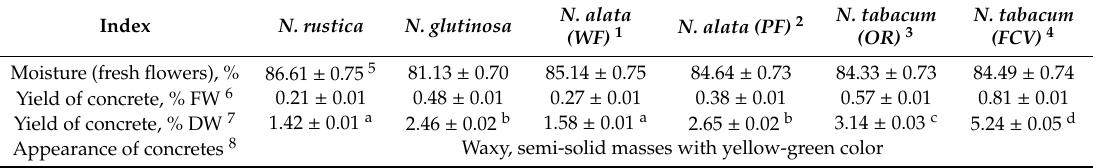
Table 1. Basic indices of the plant material ( Nicotiana flowers) and the obtained concretes.